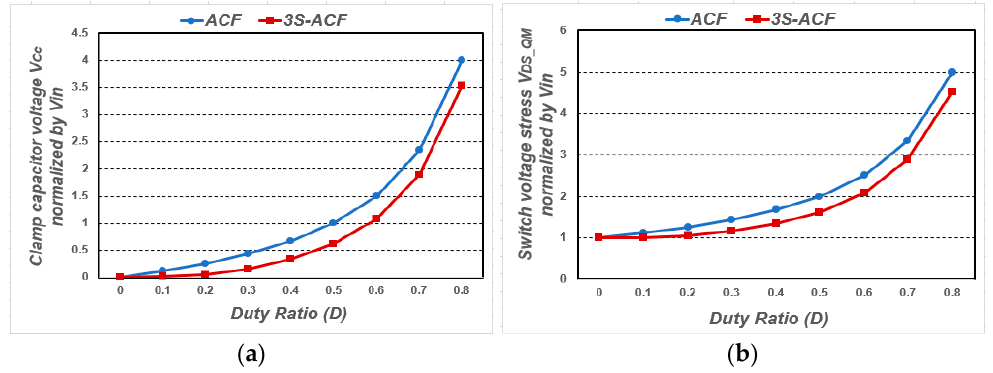
Figure 2. Voltage stress normalized by V in ( a ) clamp capacitor; ( b ) main switch Q M .